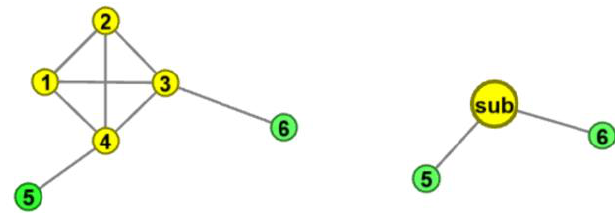
Figure 1. Example of Complete subgraph folding.